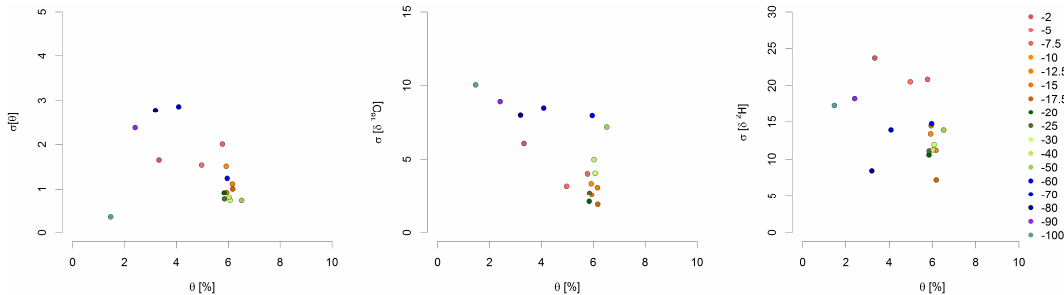
Figure 7. Mean soil moisture ( (cid:56) ) for each depth plotted against the standard deviation of soil moisture σ [ (cid:56) ] between each depth as well as standard deviation of σ [ δ 18 O] and σ [ δ 2